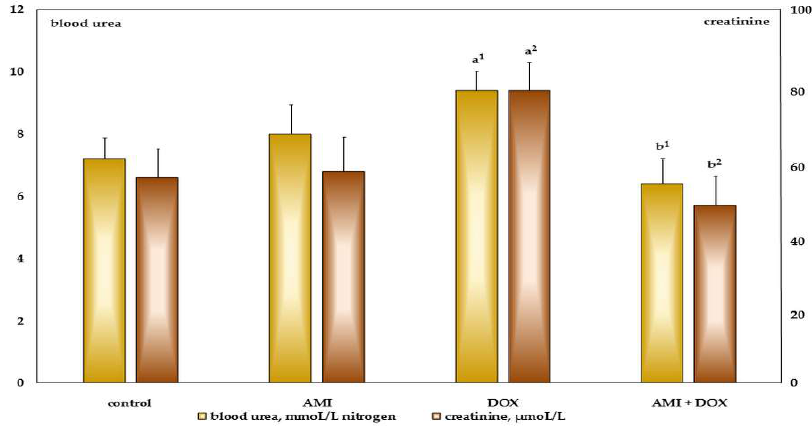
Figure 3. The influence of the treatment with amifostine and/or doxorubicin on blood urea nitrogen and creatinine serum content 28 days after receiving last treatment. a 1 , a 2 — p < 0.05, 0.01 in comparison to the control group; b 1 , b 2 — p < 0.05, 0.01 in comparison to the DOX-only treated group.